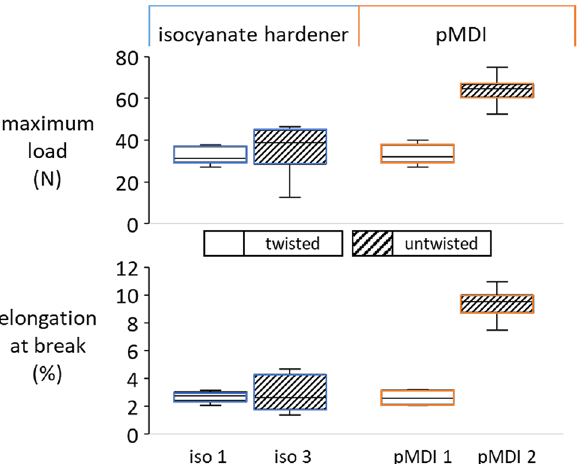
Figure 5. Maximum tensile load and elongation at break of twisted (white) and untwisted (grey) viscose yarns treated with isocyanate hardener (iso) and pMDI, respectively.